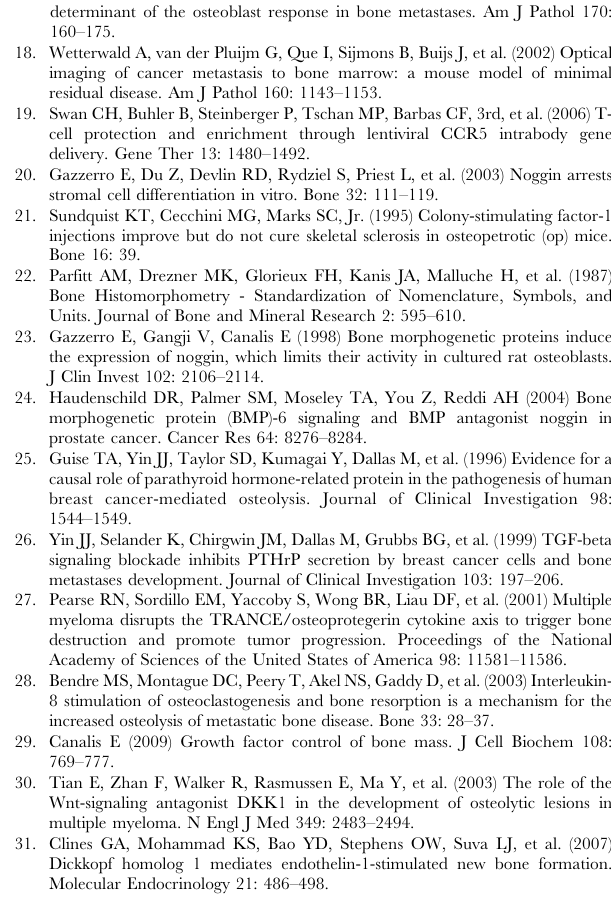
Table S2 Assay ID of the real-time primers and probes obtained from Applied Biosystems are